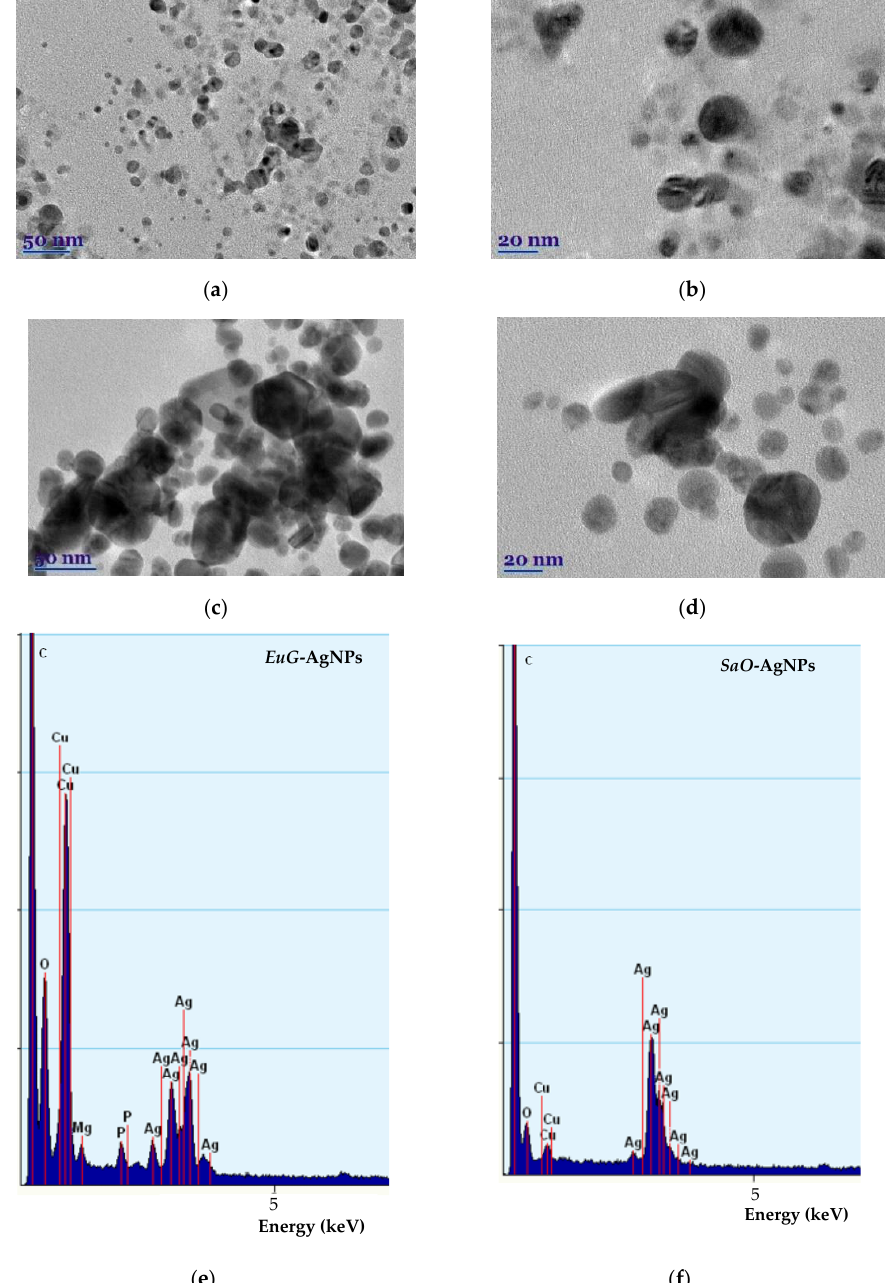
Figure 5. TEM images ( a – d ) and EDS spectra ( e , f ) of biosynthesized EuG- AgNPs ( a , b , e ) and SaO -AgNPs ( c , d , f ).